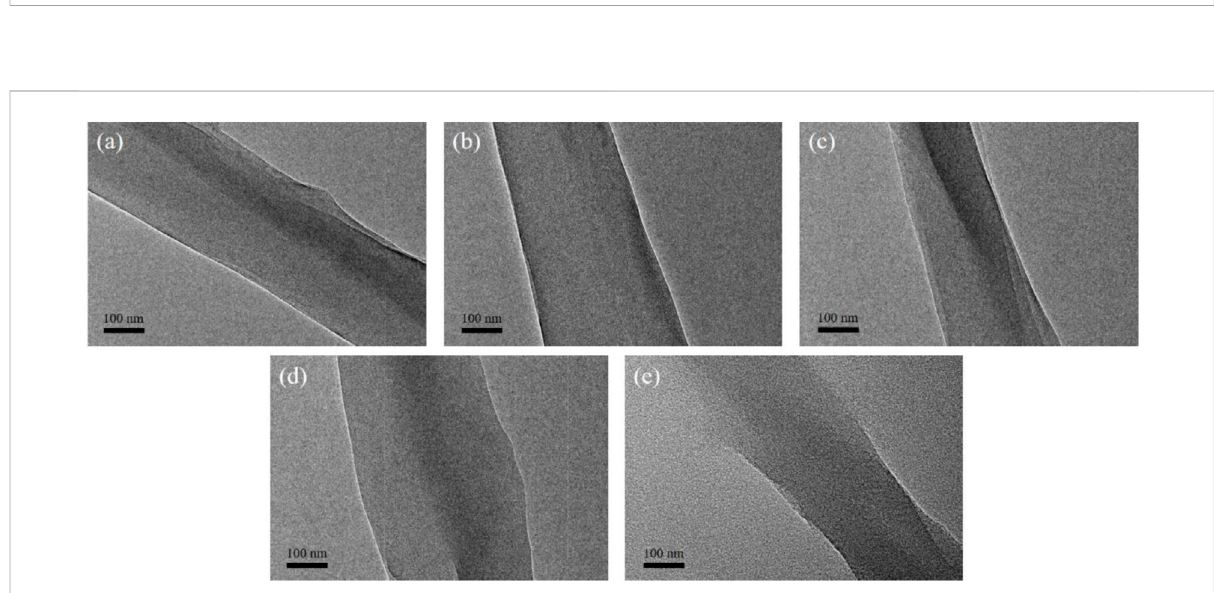
RepresentativeTEMimagesofthedegummedsilk fi berfromthe (A) controlgroup, (B) Mo-0.05 g/Lgroup, (C) Mo-0.1 g/Lgroup, (D) Mo-0.5 g/ L group, and (E) Mo-1 g/L